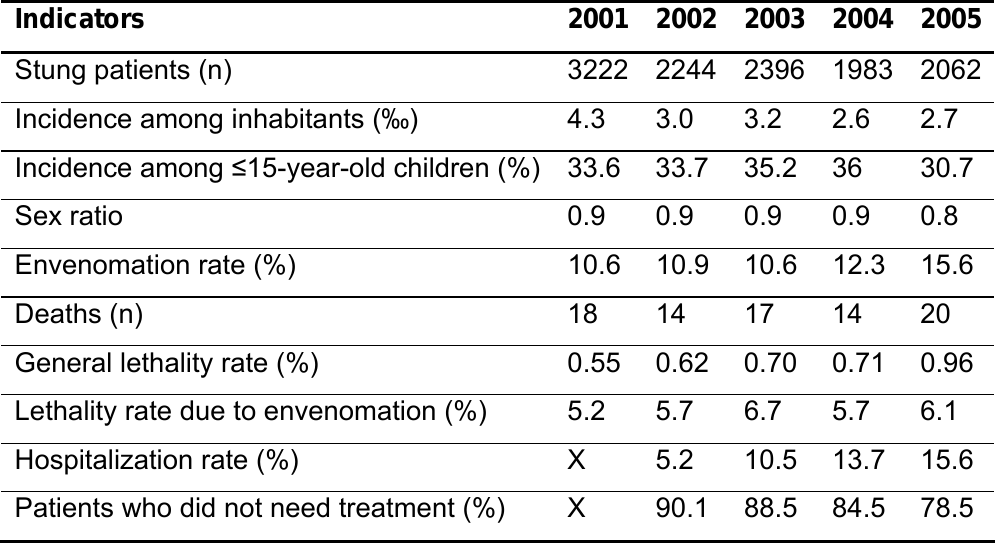
Figure 3. Distribution of scorpion stings in Morocco showing three different areas: low incidence without death; high incidence without death; and high incidence with death. Table 1. Follow-up indicators of scorpion stings in the province El Kelaa des Sraghna, Morocco, over five